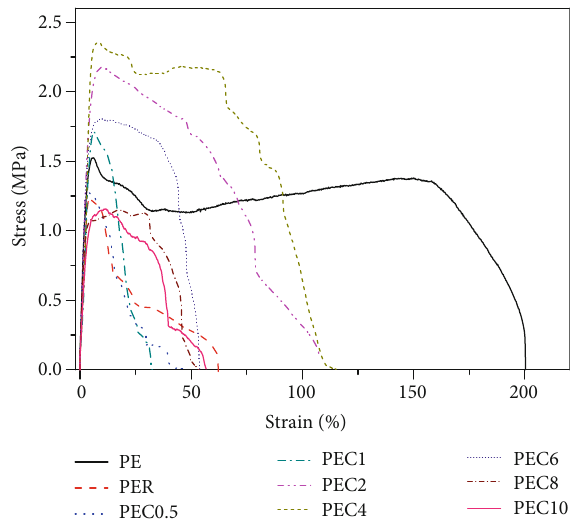
Figure 10: Stress-strain behavior of the polymer and its recycled composites. Table 2: Tensile parameters like tensile strength, modulus, and strain